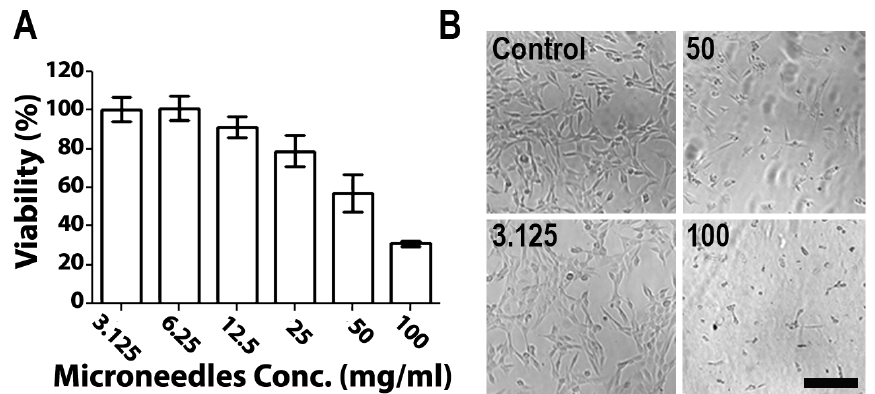
Figure 4. ( A ) NIH 3T3 cell viability compared with unexposed cells and ( B ) microscopic images of cells exposed to increased concentrations of microneedles. Scale bar: 200 µm.